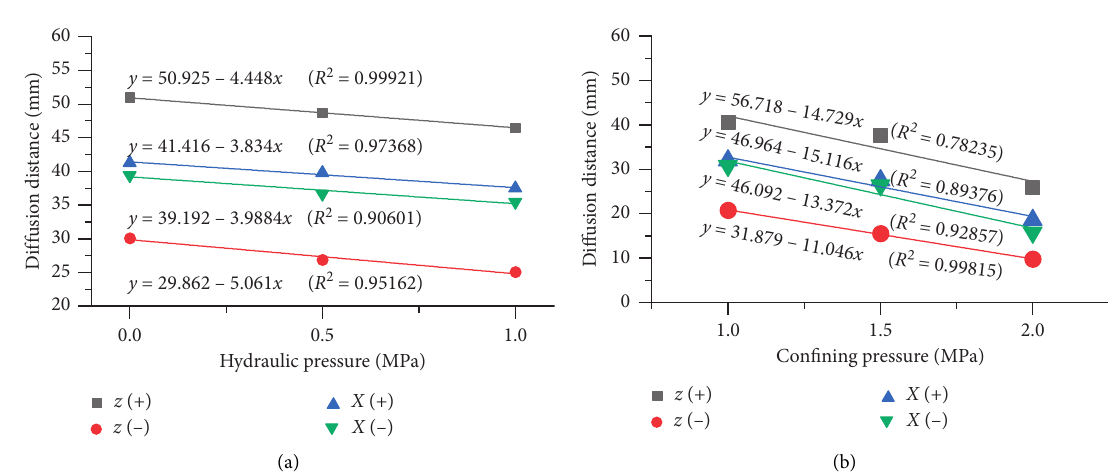
Figure 7: Measured diffusion distances versus (a)hydraulic pressure and (b)confining